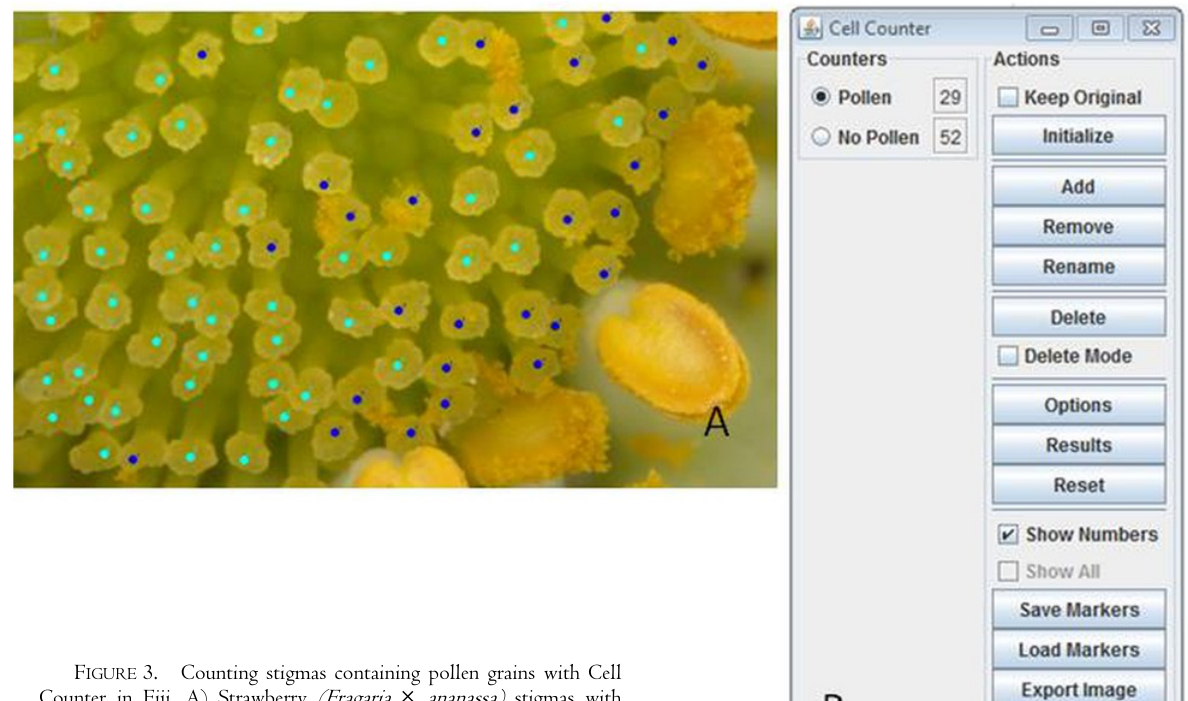
F IGURE 3. Counting stigmas containing pollen grains with Cell Counter in Fiji. A) Strawberry (Fragaria × ananassa) stigmas with pollen (blue) and without pollen (green) selected using the Cell Counter tool. B) The Cell Counter